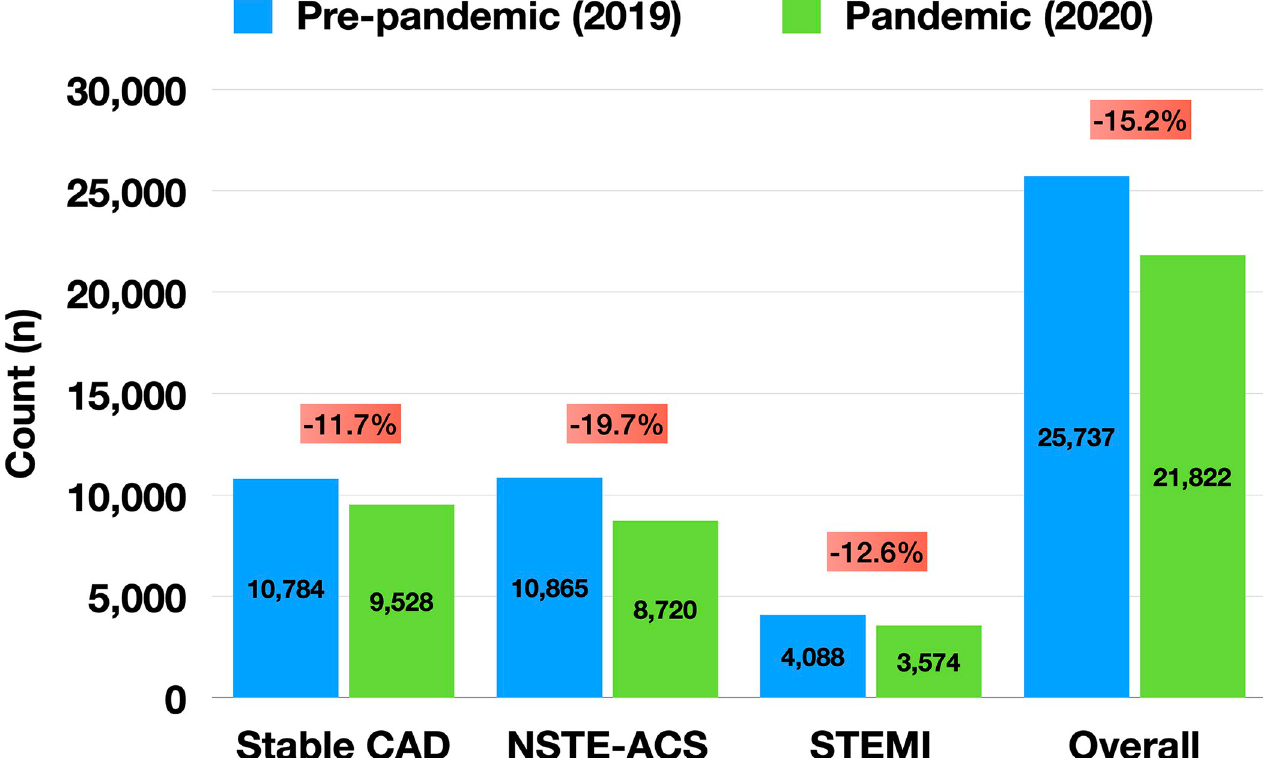
Fig 1. Percutaneous coronary intervention (PCI) volumes for various indications in the pre-pandemic vs. pandemic period. Abbreviations: CAD, coronary artery disease; NSTE-ACS, non-ST-elevation acute coronary syndrome; STEMI, ST-elevation myocardial infarction.